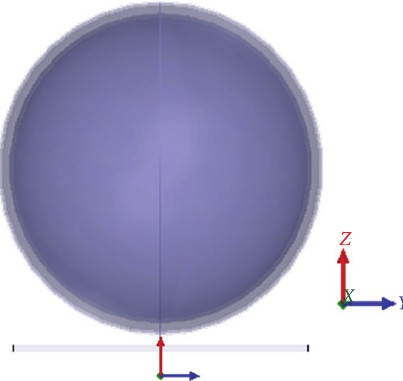
F 3: Six-layer human head model de�ned in HFSS